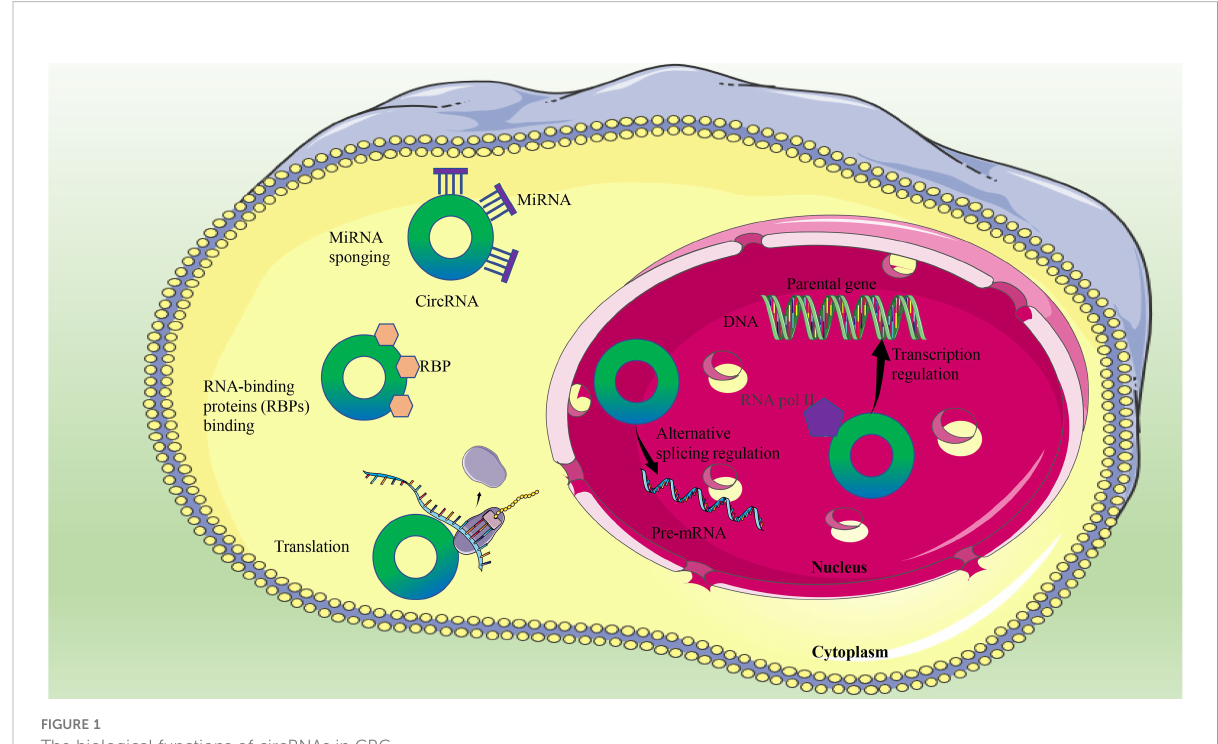
FIGURE 1 The biological functions of circRNAs in